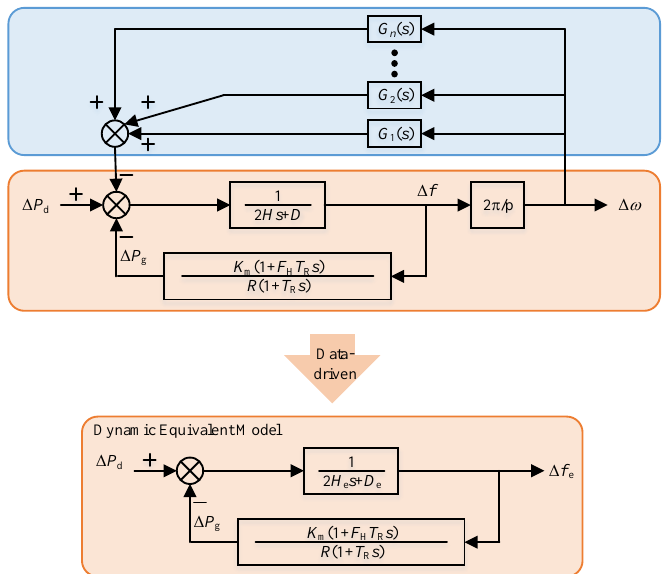
Figure 6. Block diagram of the DEM of the grid considering multiple induction